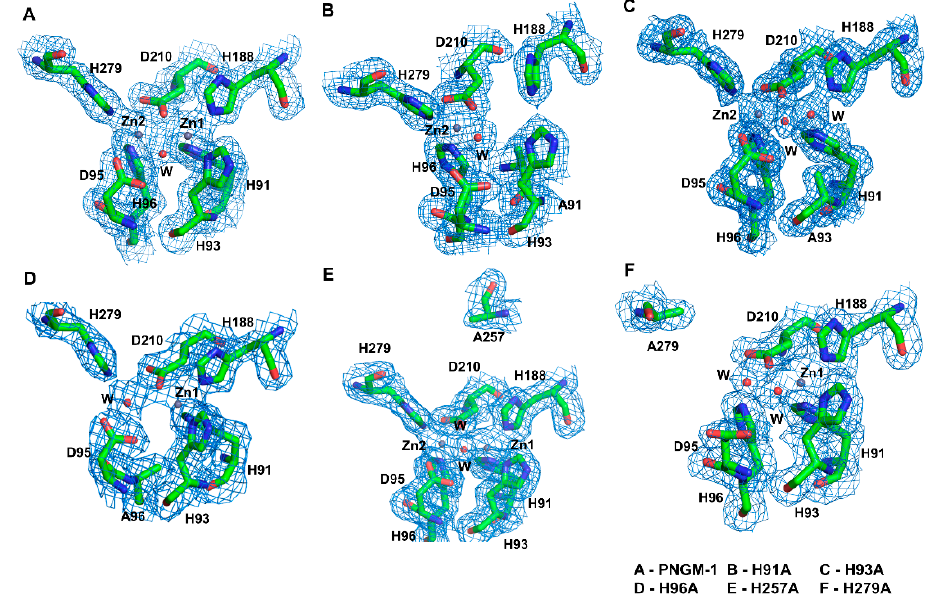
Figure 2. The metal-binding sites of PNGM-1 wild-type and variants. The 2FoFc electron density maps contoured at 1.0 e/Å 3 are shown (blue mesh) for ( A ) PNGM-1 wild-type, ( B ) H91A variant, ( C ) H93A variant, ( D ) H96A variant, ( E ) H257A variant, and ( F ) H279A variant.